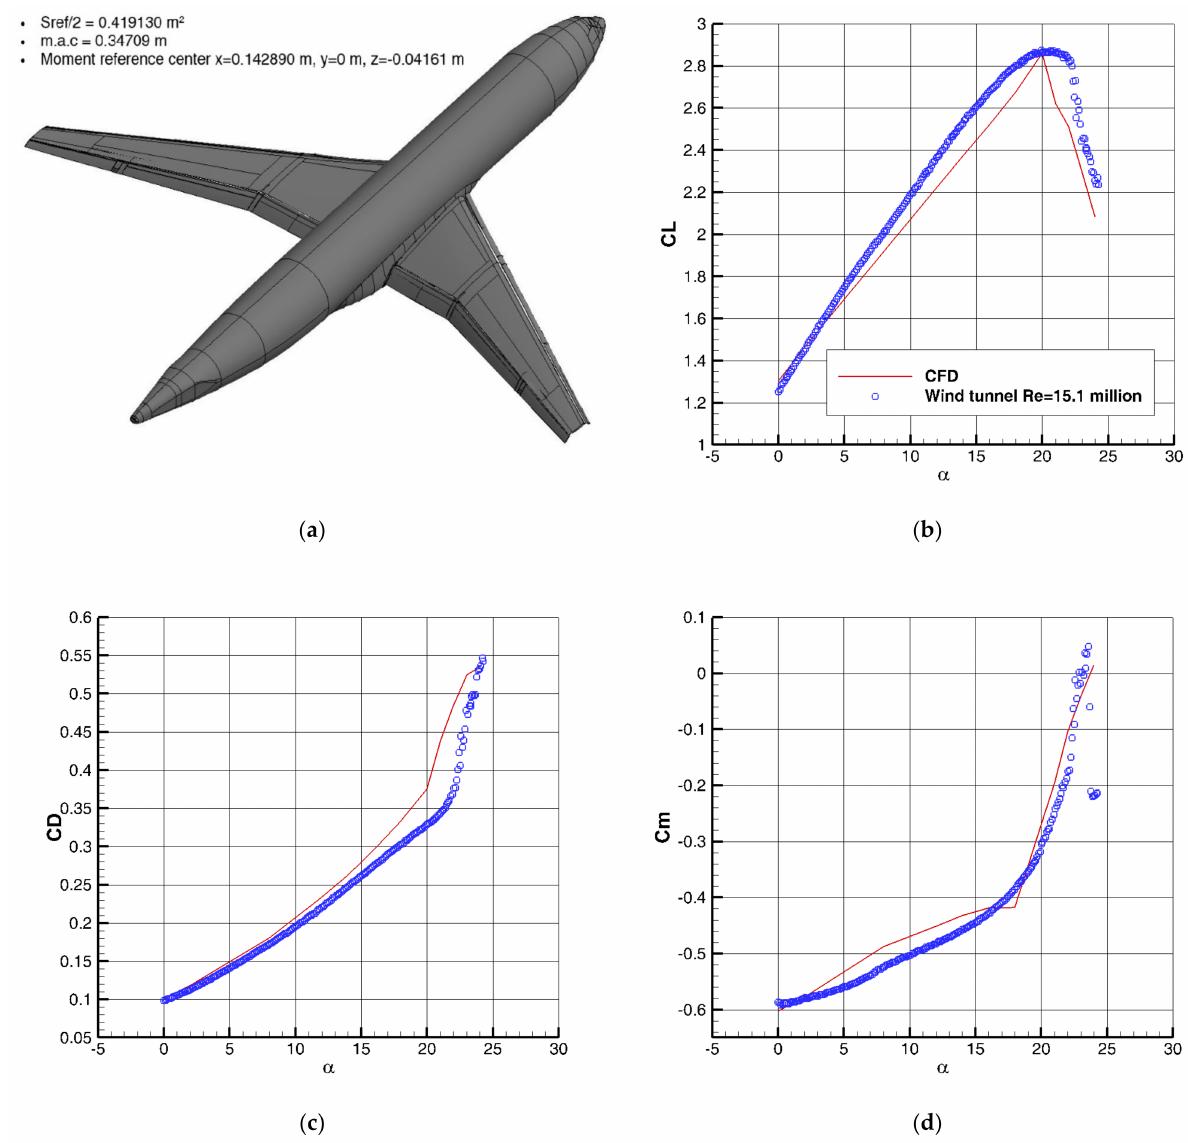
Figure 6. Low-speed test case CFD validation: ( a ) DLR-F11 model; ( b ) C L − α diagram; ( c ) C D − α diagram; ( d ) C m − α